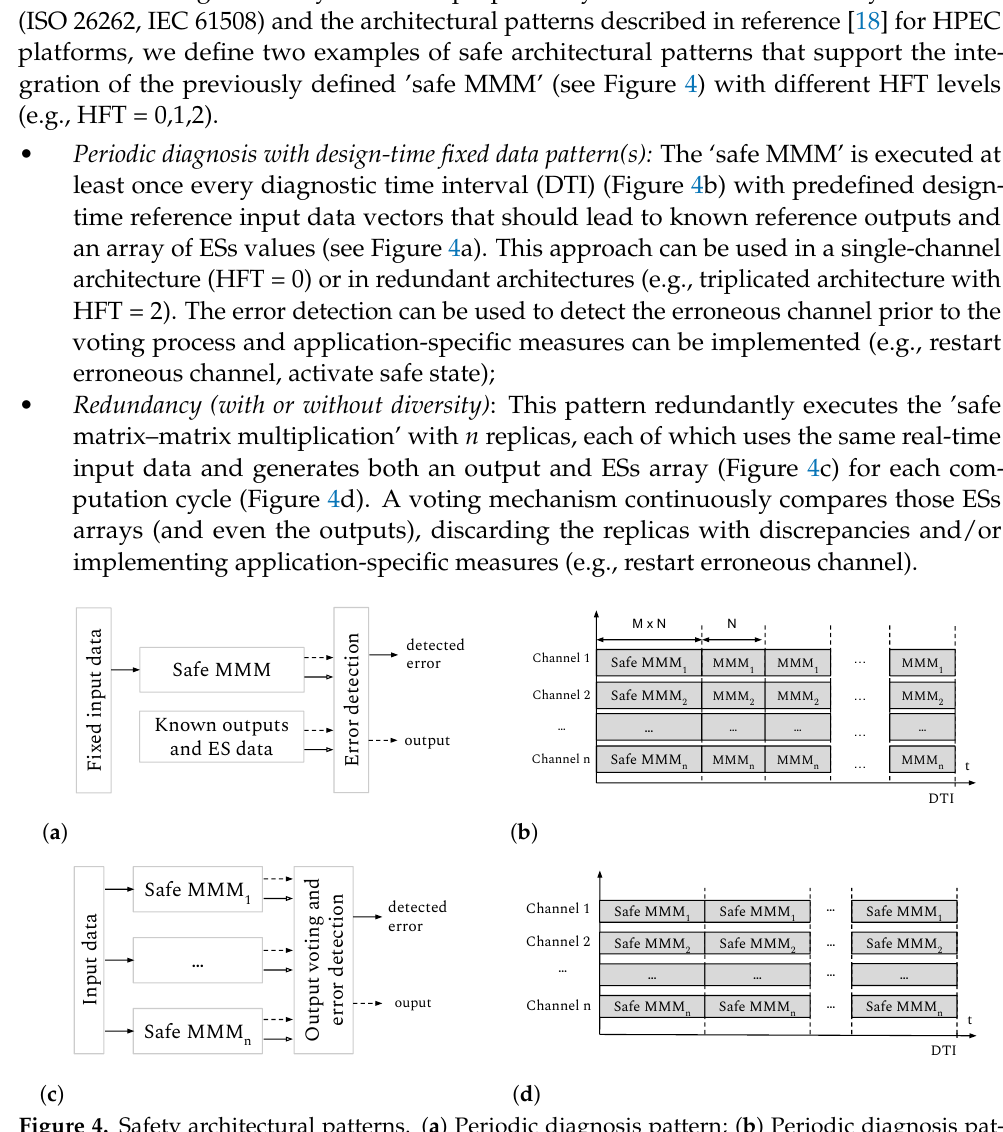
Figure 4. Safety architectural patterns. ( a ) Periodic diagnosis pattern; ( b ) Periodic diagnosis pat- tern scheduling; ( c ) Redundancy pattern; ( d ) Redundancy pattern